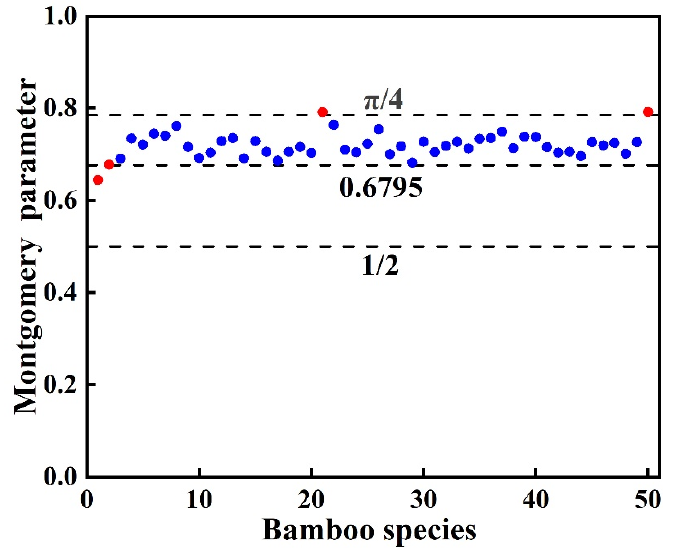
Figure 3. Montgomery parameter ( α ) of 50 bamboo species. The theoretical value of α ranged from 1/2 to π /4, and the theoretical value of α of Poaceae plants ranged from 0.6795 to π /4.